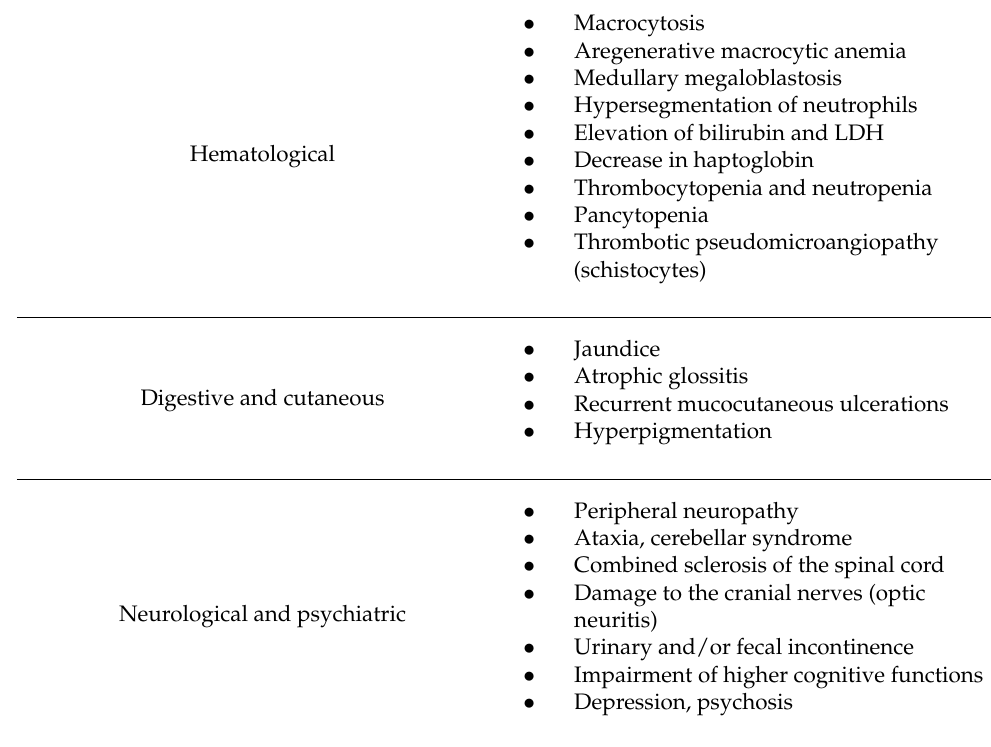
Table 2. Main clinical and biological manifestations of vitamin B12